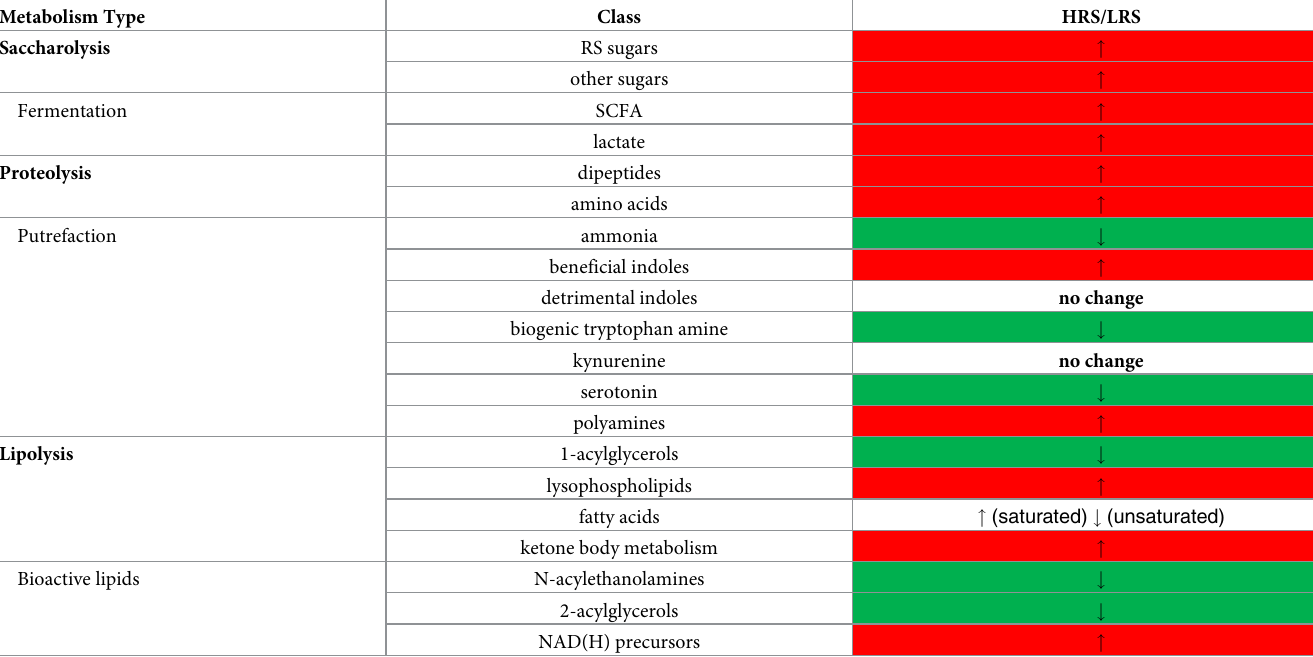
Table 2. Summary of metabolite class